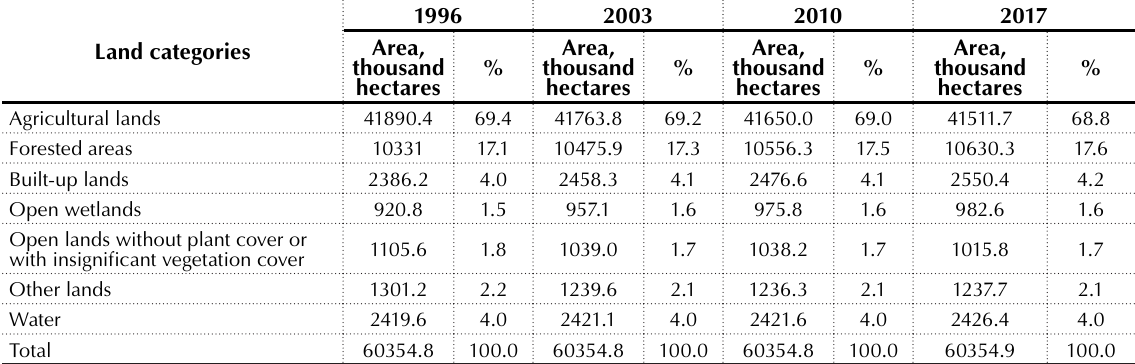
Table 1. Land distribution of Ukraine by categories as of January 1, 2017 Source: Proposed on the basis of data analysis of The State Geographical Cadaster of